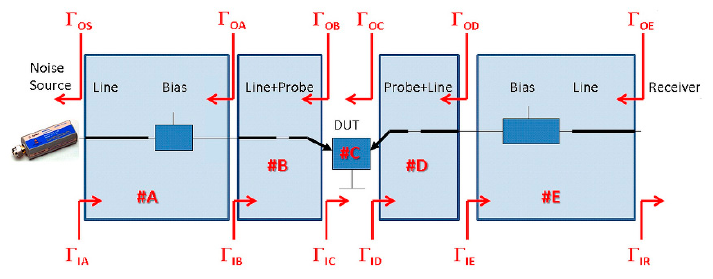
Figure 5. Notional measurement setup at NRL.